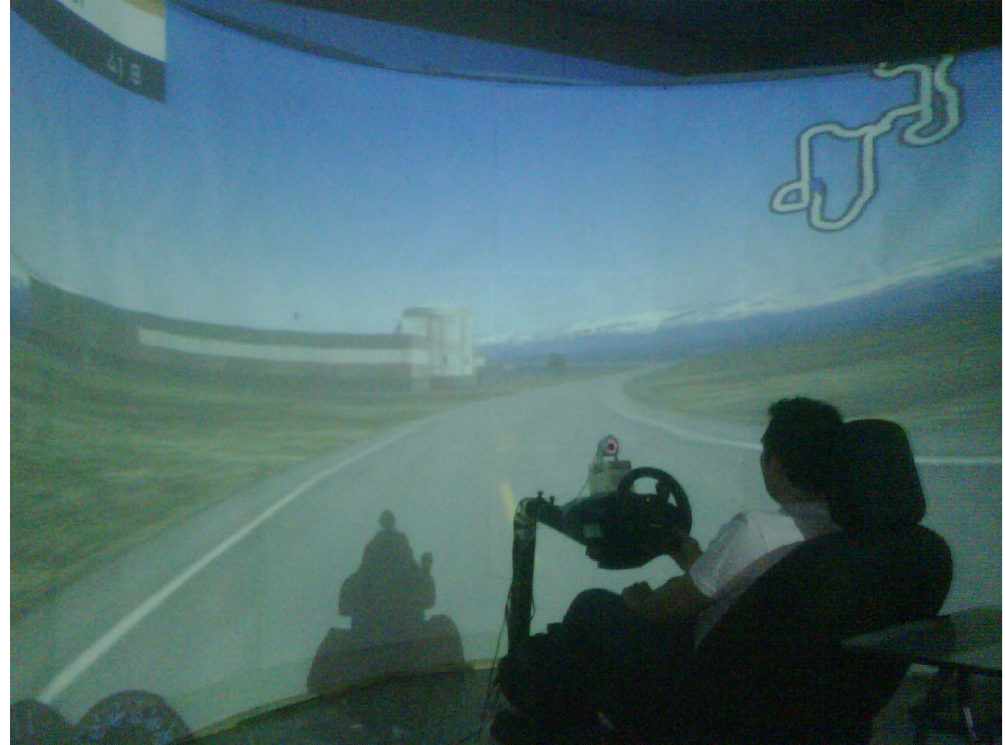
Figure 10. Driving simulator during one of the experiments.